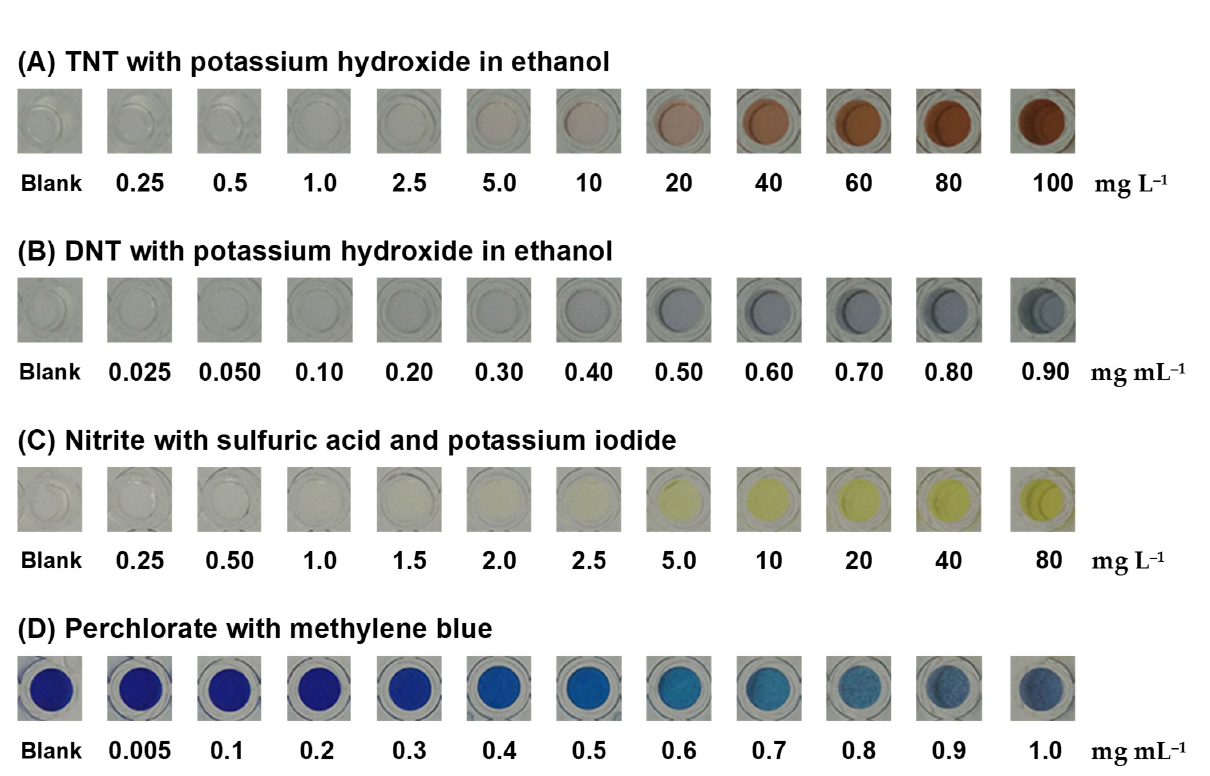
Figure 5. Colorimetric products of ( A ) TNT and ( B ) DNT were produced with potassium hydroxide in ethanol. Colorimetric products of ( C ) nitrite were produced with sulfuric acid and potassium iodide and colorimetric products of ( D ) perchlorate were produced with methylene blue.